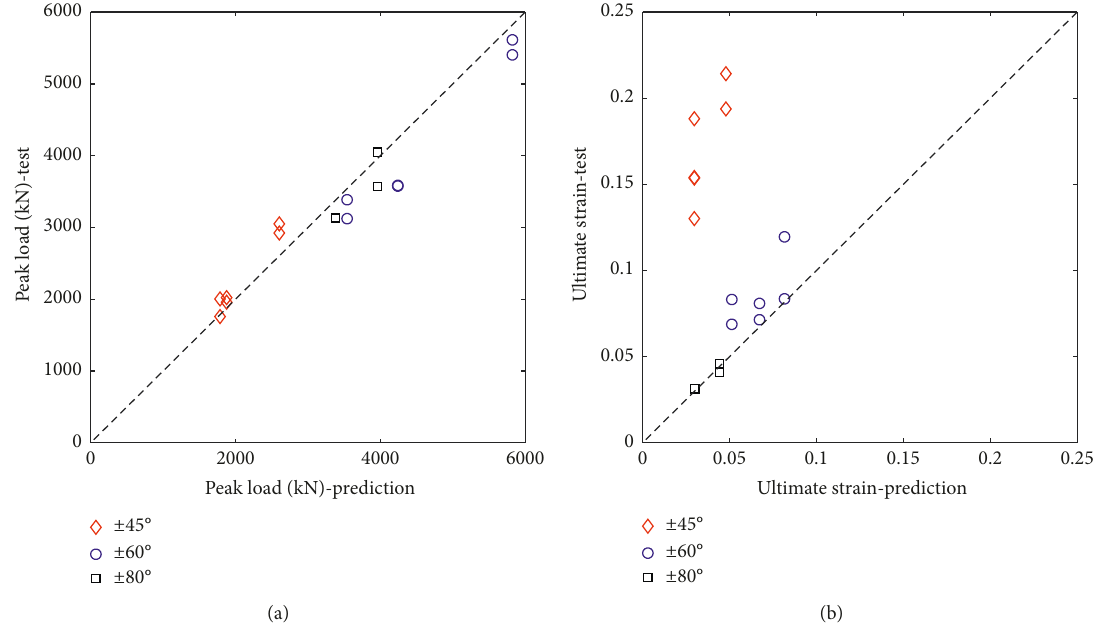
Figure 19: Predictions of Wang’s [32] model. (a) Peak load. (b) Ultimate axial